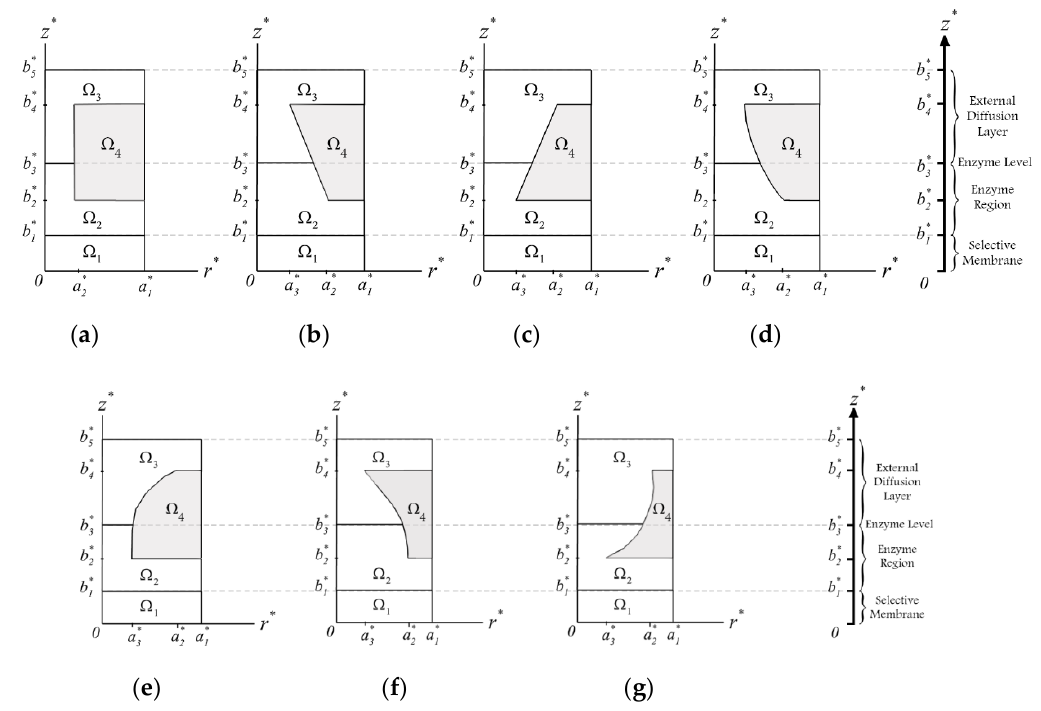
Figure 2. The geometries of the biosensor unit cell: ( a ) cylindrical, ( b ) upward circular cone, ( c ) downward circular cone, ( d ) upward paraboloid, ( e ) downward paraboloid, ( f ) upward concave paraboloid, and ( g ) downward concave paraboloid. Figures are not to scale.